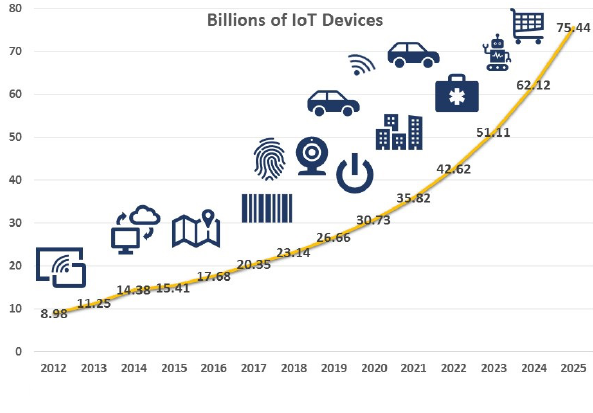
Figure 1. Internet of things (IoT) devices in billions over the